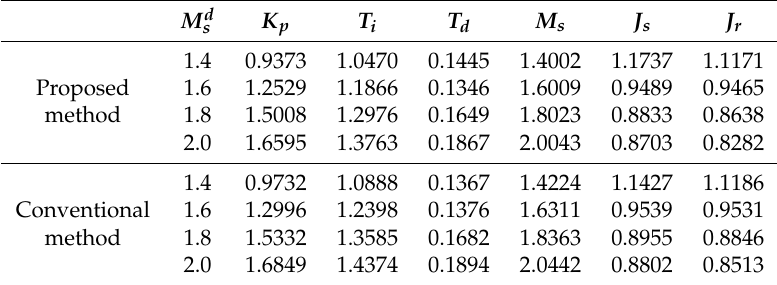
Table 6. Proportional-integral-derivative parameters, M s , and SAE values in the servo design using Equation (44).